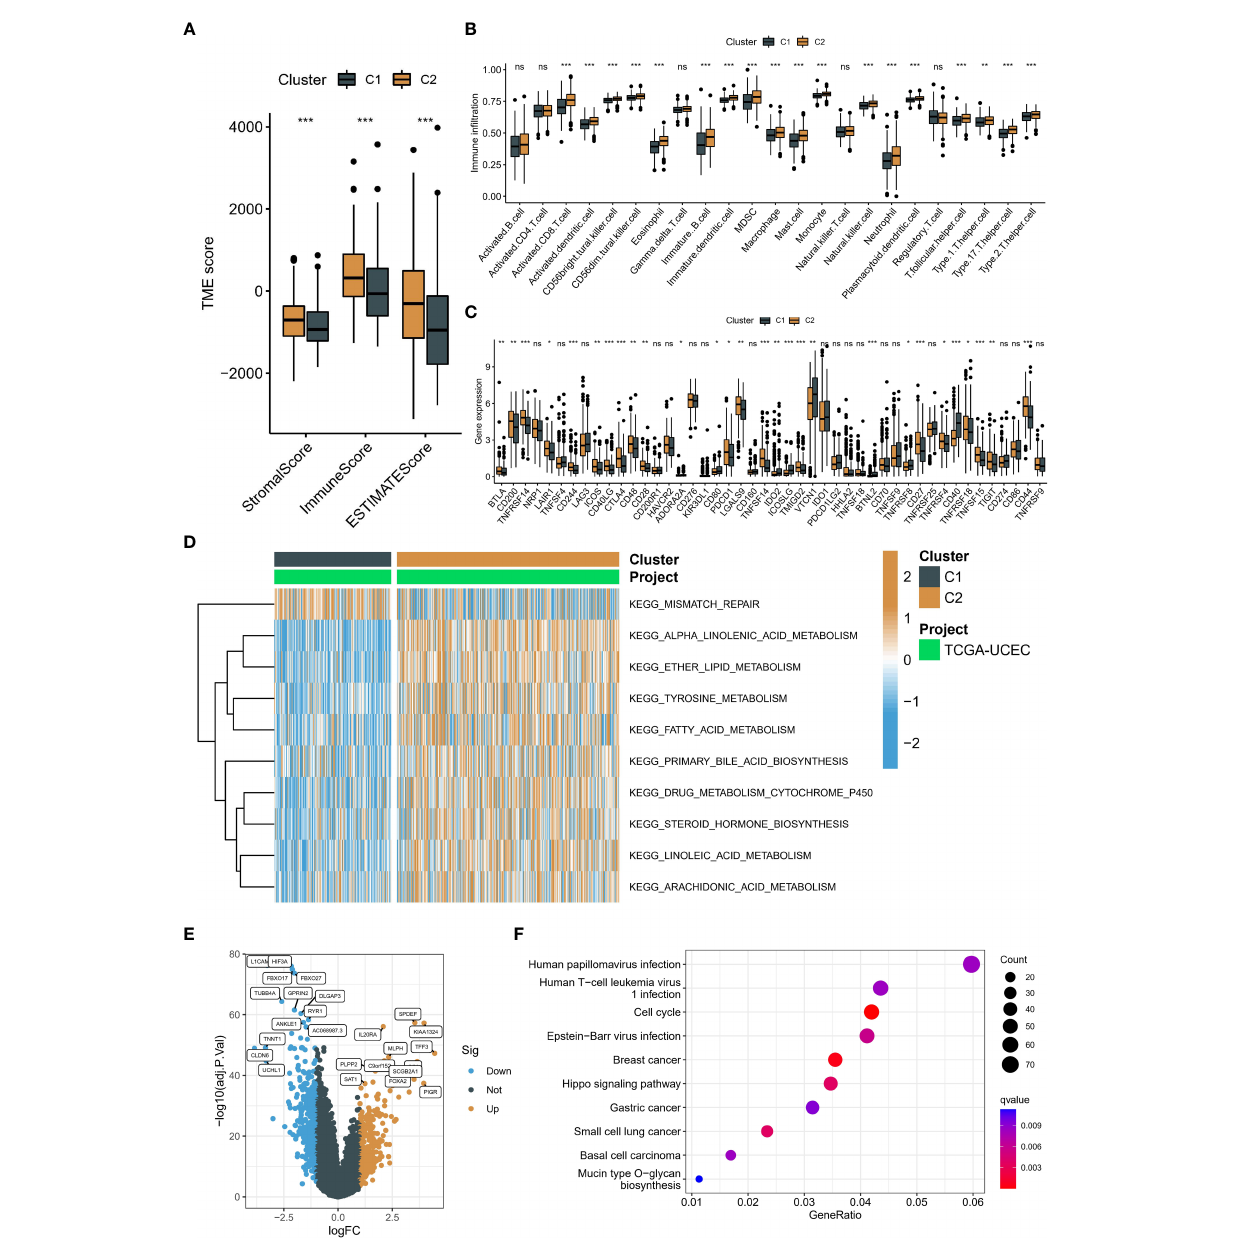
FIGURE 4 Immune landscape and biological function in two patterns associated with neddylation. (A) Overall TME status between the two patterns based on ESTIMATE algorithm. (B) Abundance of 24 immune cells based on ssGSEA algorithm. (C) Differences in mRNA associated with immune checkpoint inhibitors. (D) Heatmap of matrix of KEGG enrichment scores using GSVA algorithm. (E) Volcano map showed DEGs between two patterns. (F) KEGG enrichment analysis of DEGs. ns, no statistical signi fi cance; *p < 0.05, **p < 0.01, ***p <